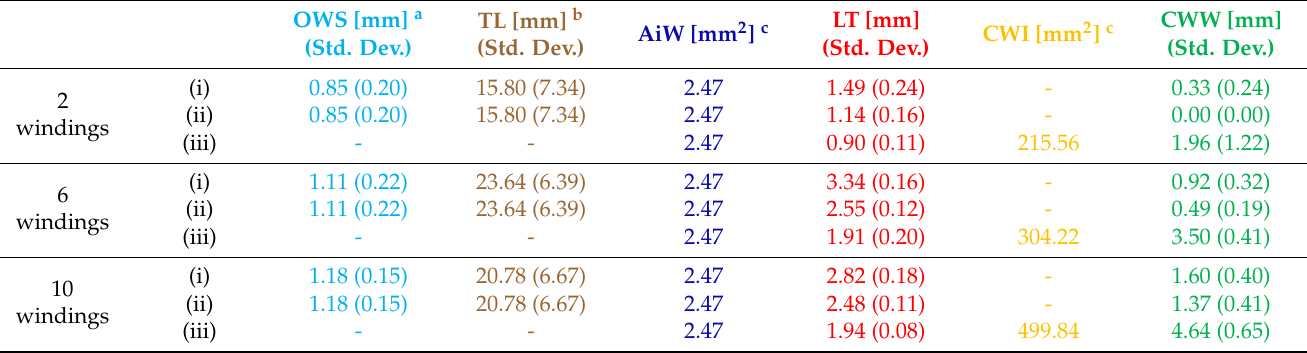
Table 2. Characteristic dimensions of simple loops with two, six and ten